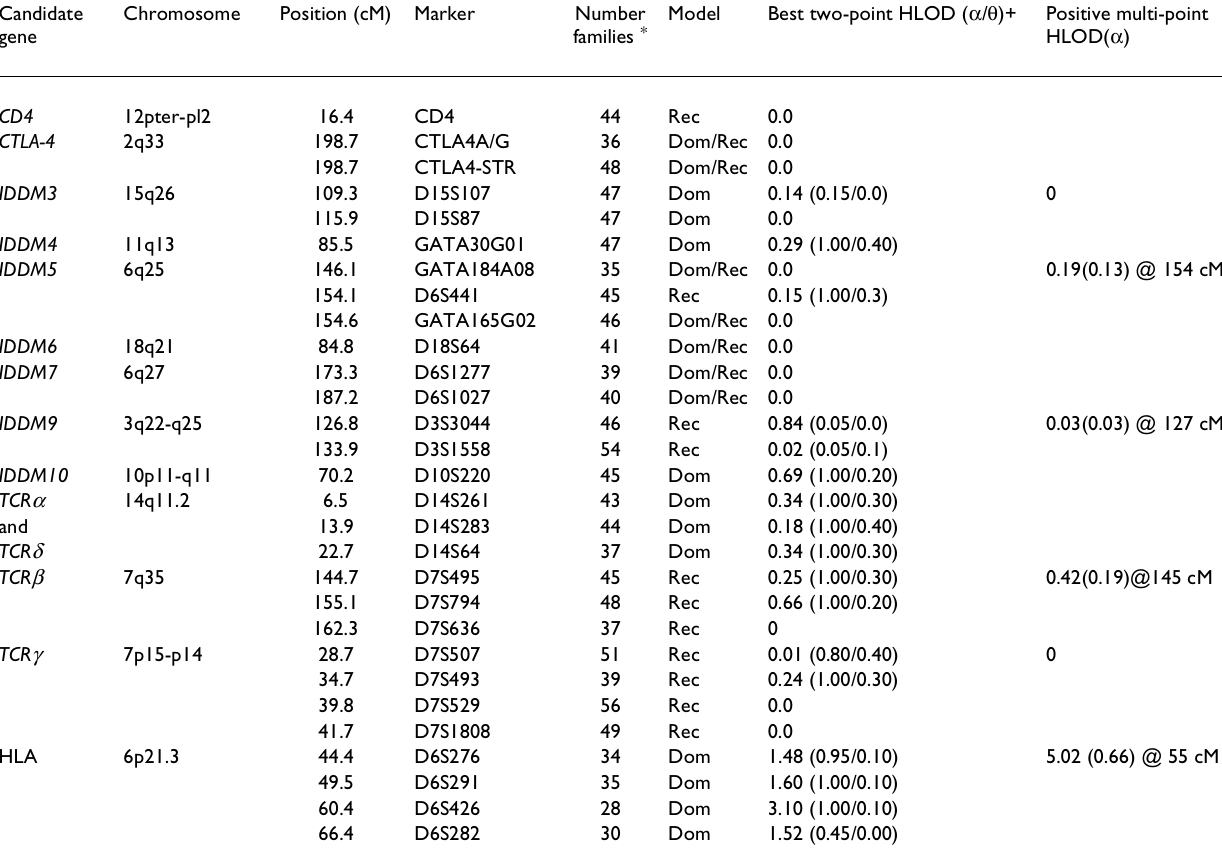
Table 2: Two-point and Multi-point HLODs at Markers for HLA and 13 Candidate Genes Candidate